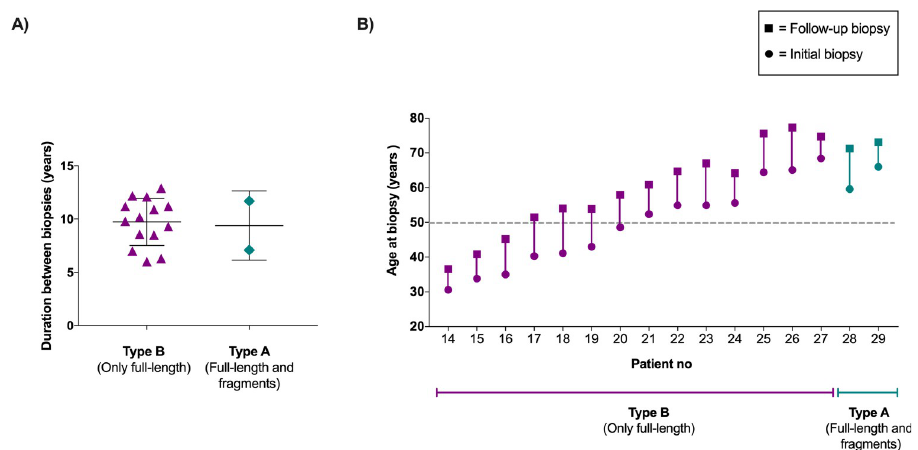
Fig 3. Duration and age, for patients from whom a long-term biopsy was collected for this study. (A) Duration between the initial and follow-up biopsy grouped according to fibril type. Horizontal lines represent the mean value ± standard deviation. (B) Age at the initial and the long-term follow-up biopsy. The grey dashed line represents the age at disease onset (50 years old) which most often is used to determine a patient as “early or late